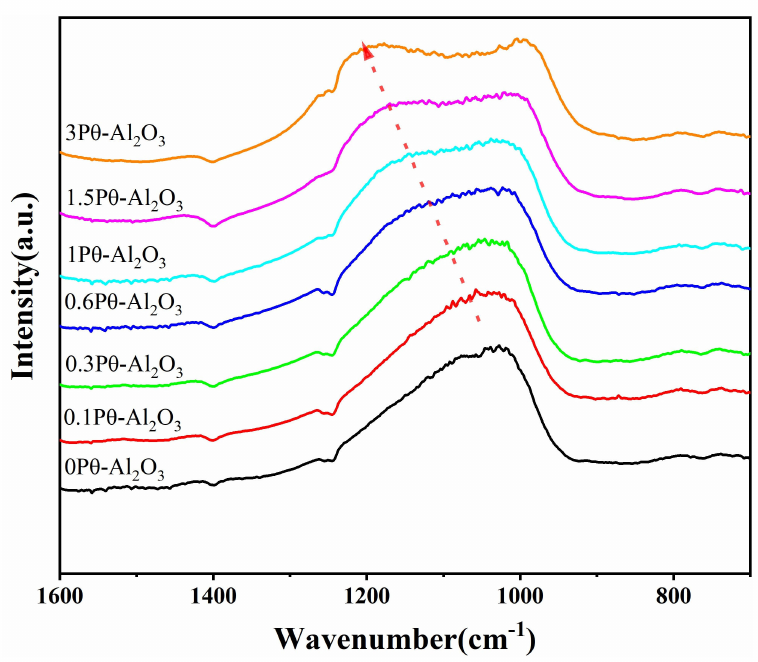
Figure 3. FT − IR profiles of